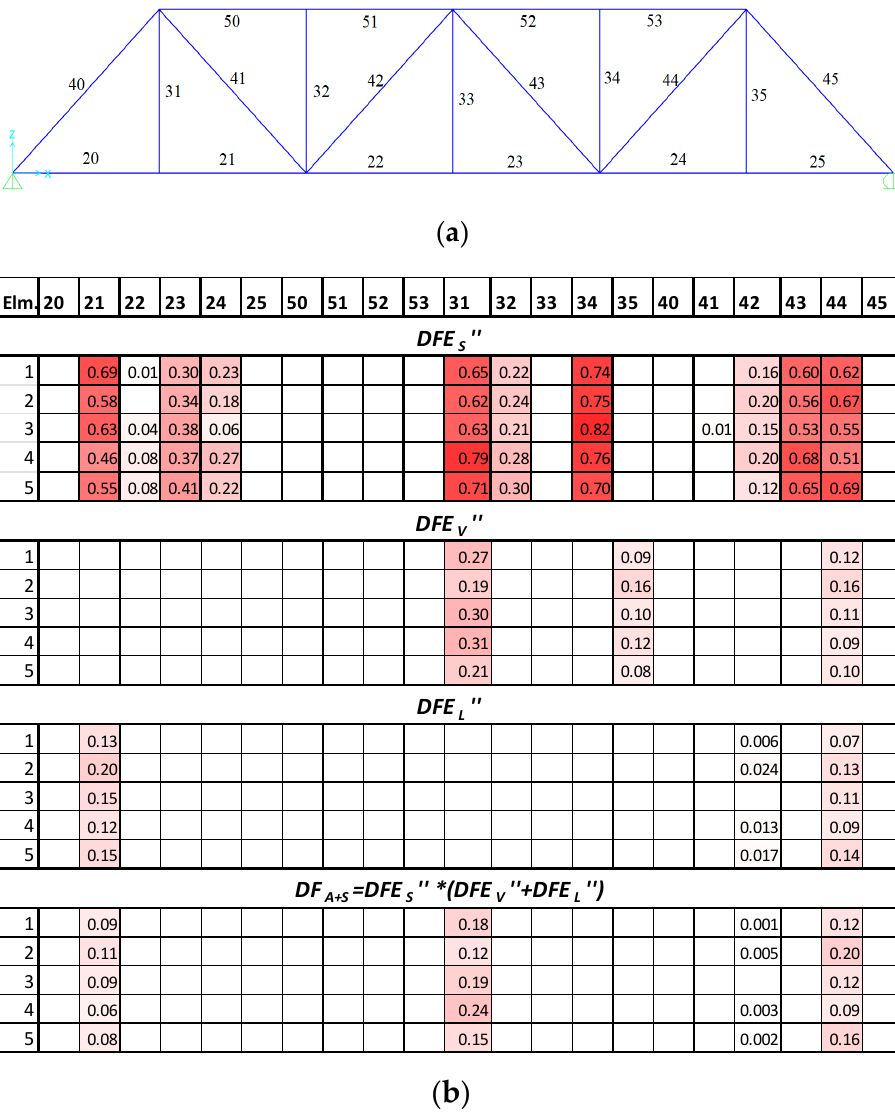
Figure 14. ( a ) The actual location of damage for damage case-6, ( b ) Identified damage using the proposed framework for damage case-6.